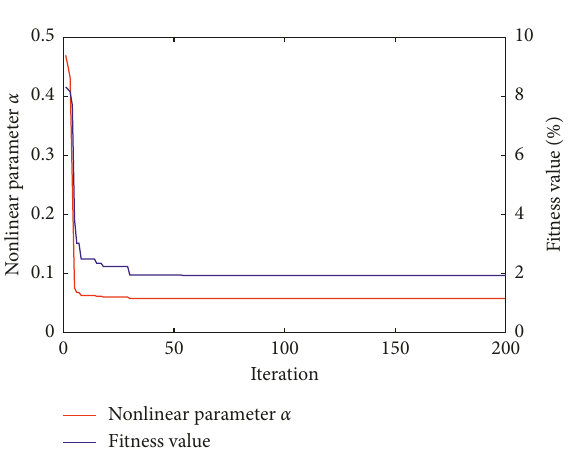
Figure 9: Convergence curve of WOA in Case